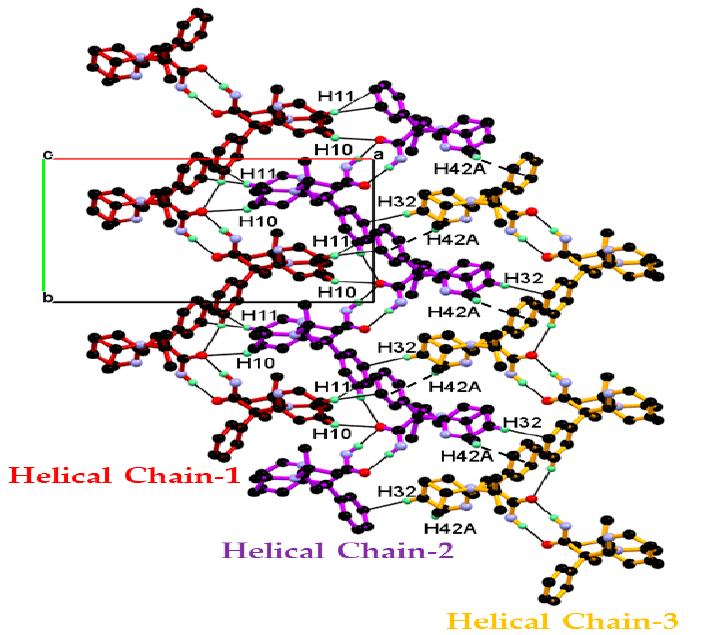
Figure 5. Helical 1-D chain of dimeric unit of DPA is assembled in the ab -plane resulting in 2-D packing. In this packing, the central 1-D dimeric unit chain of DPA molecules is associated with the neighboring dimeric chain via C-H ∙∙∙ O and C-H ∙∙∙π interaction and the resulting tight packing in the ab -plane.